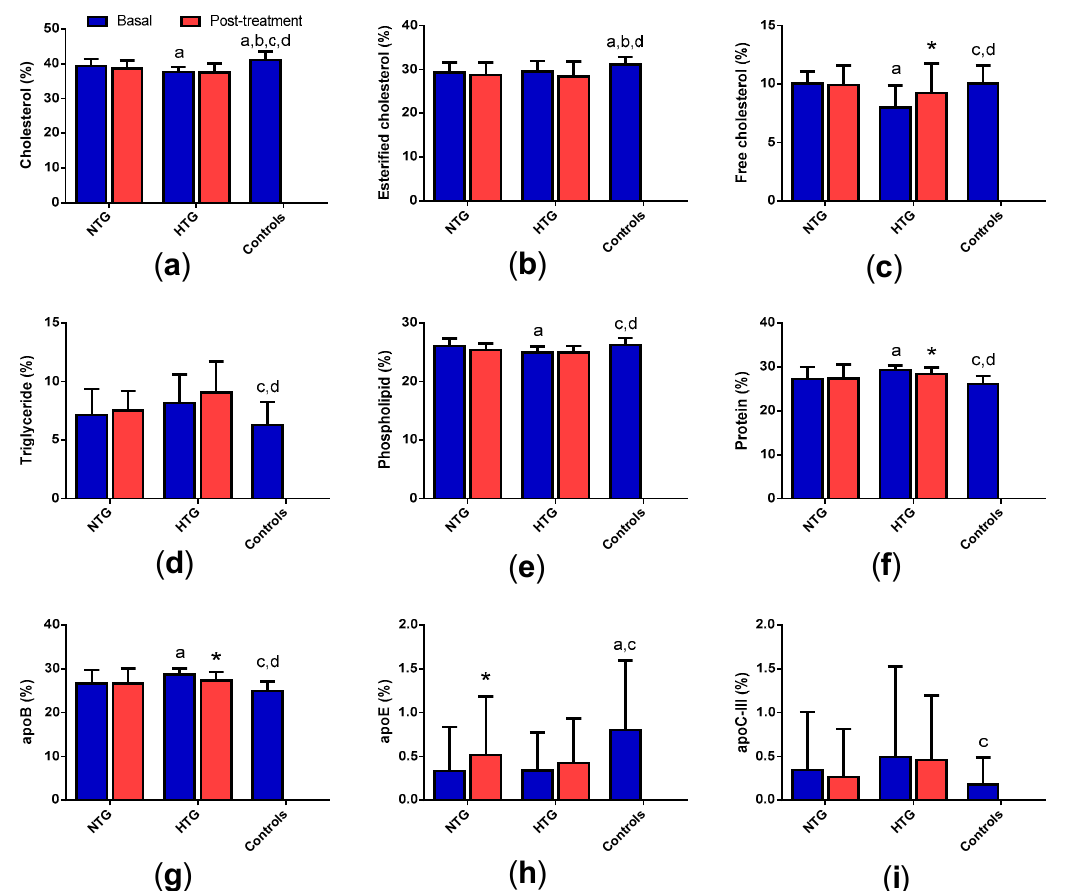
Figure 4. LDL composition. Data indicate the relative proportion of each component of the LDL mass and are expressed as mean ± SD. ( a ) total cholesterol, ( b ) esterified cholesterol, ( c ) free cholesterol, ( d ) triglycerides, ( e ) phospholipids, ( f ) total protein, ( g ) apoB, ( h ) apoE, ( i ) apoC-III. * p < 0.05 vs. basal samples. a p < 0.05 vs. basal NTG. b p < 0.05 vs. NTG post-treatment. c p < 0.05 vs. basal HTG. d p < 0.05 vs. HTG post-treatment.